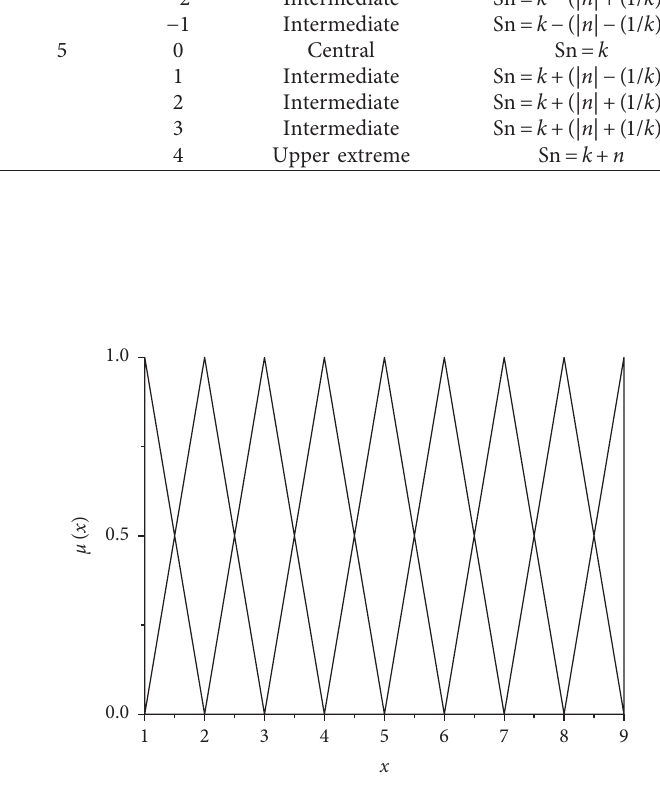
Figure 3: Graphical representation of a 9-point classic triangular fuzzy balanced scale.